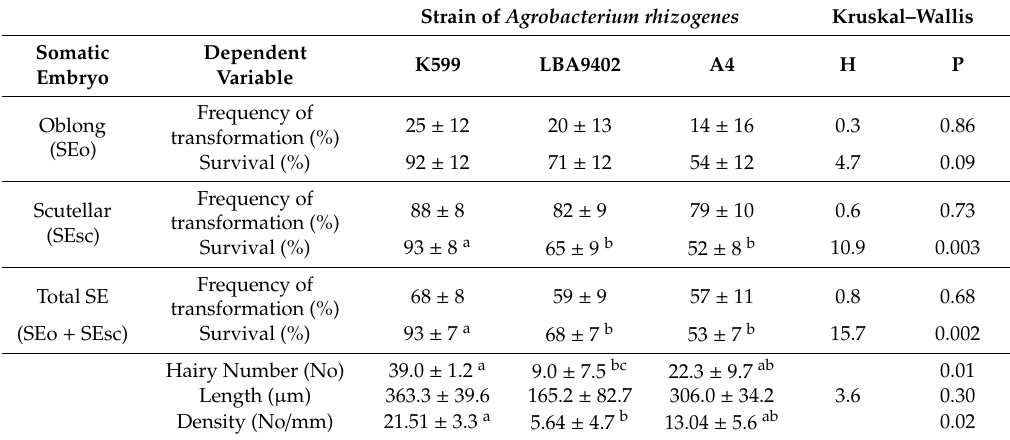
The data represent the means ± standard error of the treated embryos. Di ff erent letters in columns denote a group of means that are significantly di ff erent ( p < 0.05). H = test statistic for the Kruskal–Wallis H test; P, p -value for the Kruskal–Wallis test or from the F = Fisher LSD